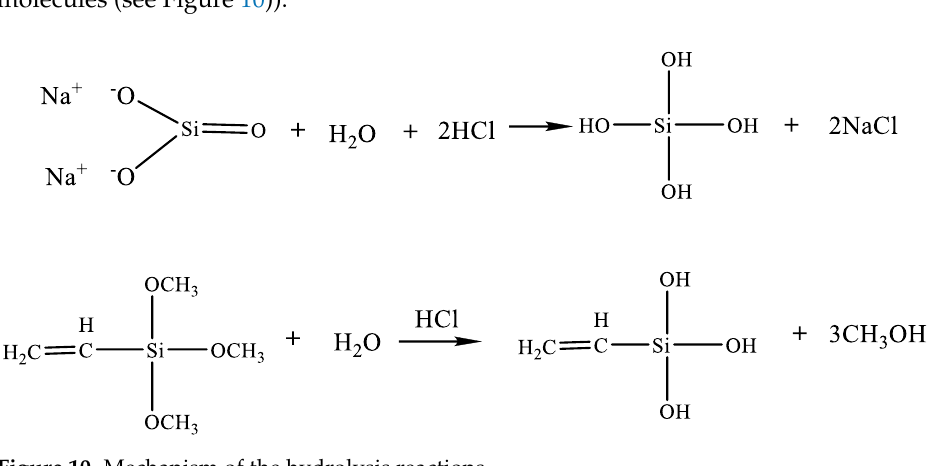
Figure 9. 29 Si NMR spectra of aerogels (V:W = 0.8).